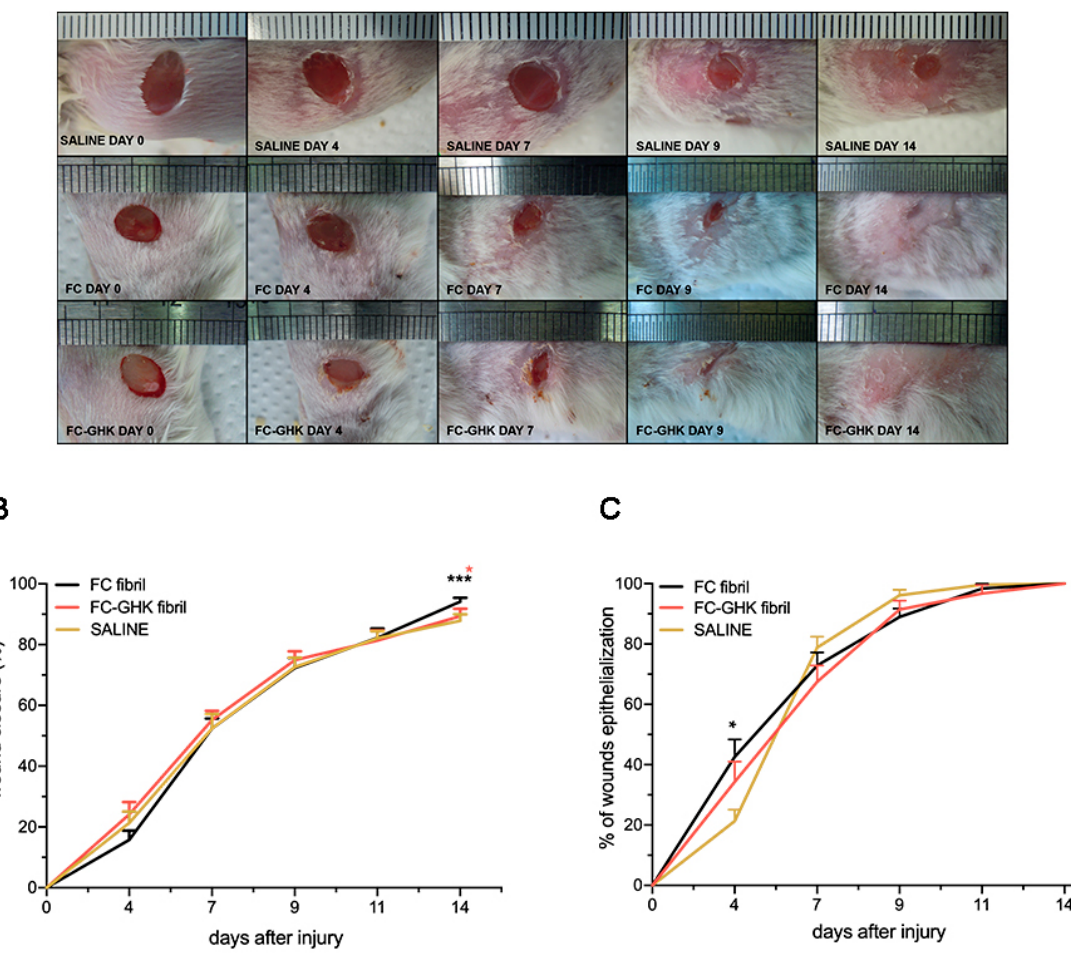
Figure 14. ( A ) Representative images of dorsal skin wounds in the control group and the groups treated with the fibrillated peptides FC and FC-GHK. The images show wound healing progress from day 0 to day 14. ( B ) The relative area of dorsal skin injuries and ( C ) and wound epithelialization of the fibrillated peptides FC and FC-GHK compared to saline over time. The graph shows the average wound area relative to the initial wound surface, and error bars represent SEM. The number of wounds n = 16 representing eight animals from both treatment groups and n = 12, representing six animals from the control group. Statistical significance was determined with the Mann–Whitney U test; one (*) and three asterisks (***) indicate p < 0.05 or p < 0.001, respectively.